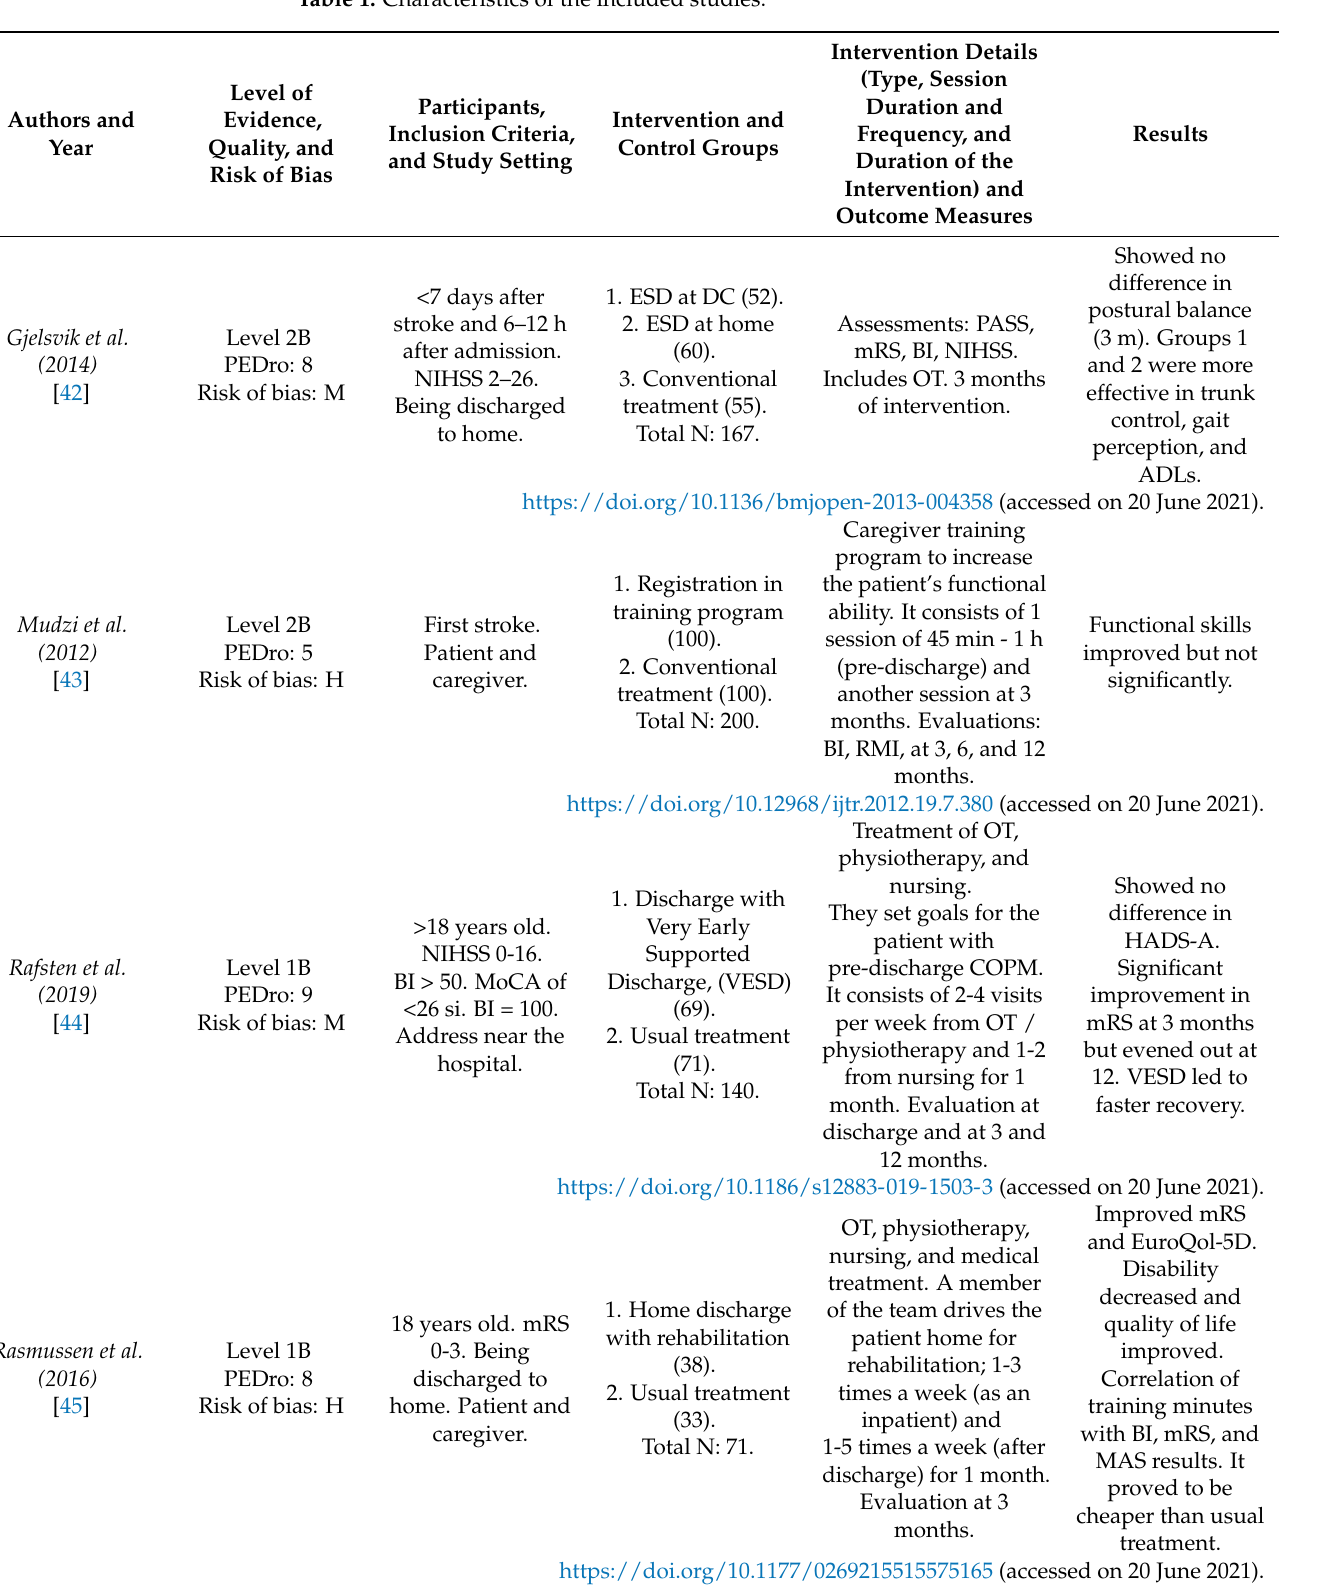
Table 1. Characteristics of the included